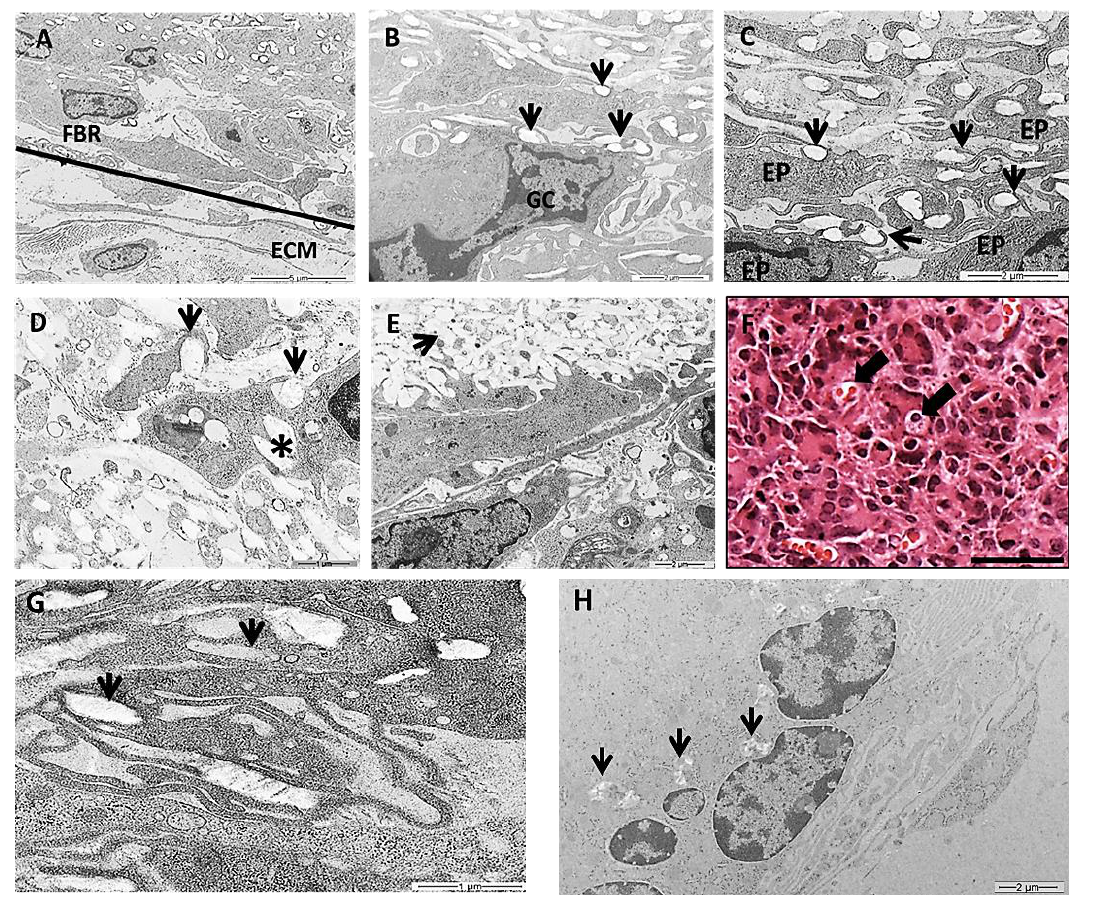
Figure 6. Transmission electron microscopy (TEM) and histological images of the inflammatory response induced by PLGA membranes. ( A ): Image showing the periphery of the PLGA with mononuclear cells forming a FBR in contact with the extracellular matrix (ECM). Scale bar: 5 µ m; ( B ): image showing PLGA fragments (arrows) in contact with a MNGC. Scale bar: 2 µ m; ( C ): image showing PLGA fragments (arrows) in contact with EP cells taking different morphologies, exhibiting prominent cytoplasmic extensions such as filopodia following the topography of PLGA fragments (arrows). Scale bar: 2 µ m; ( D , E ): 15 days PI. D: PLGA fragments inside phagosomes (arrows in D ) in the interior of the cell (asterisk in D ) (Scale bar: 1 µ m) or in the extracellular space (arrow in E ). Scale bar: 2 µ m; ( F ): Light microscopy image 30 days PI in Masson’s trichrome staining showing LC containing material inside (arrows). Scale bar: 100 µ m; ( G ): 30 days PI—PLGA fragments were swollen by cells (arrows). Scale bar 1 µ m. ( H ): Note less amount of PLGA fragments between the cells 90 days PI (arrows). Scale bar: 2 µ